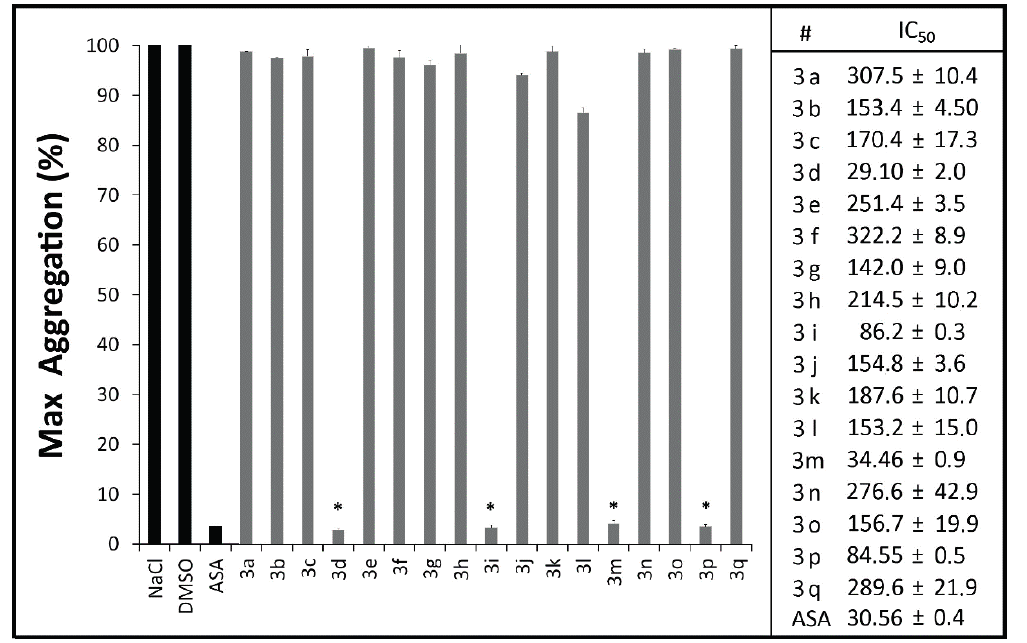
Figure 1. Antiplatelet profile of N,N' -disubstituted thiourea derivatives (100 μ M) and aspirin (ASA) on in vitro platelet aggregation of human citrated platelet-rich plasma induced by arachidonic acid (AA). The results are the mean of two experiments performed in triplicate. * p < 0.05 (oneway ANOVA, Tukey test).